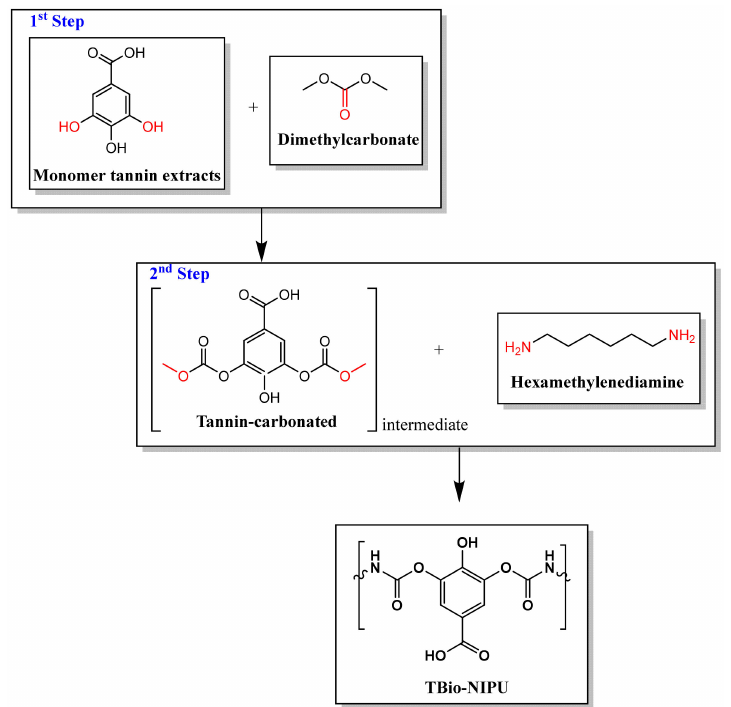
Figure 4. Possible reactions of tannin-based Bio-NIPU.